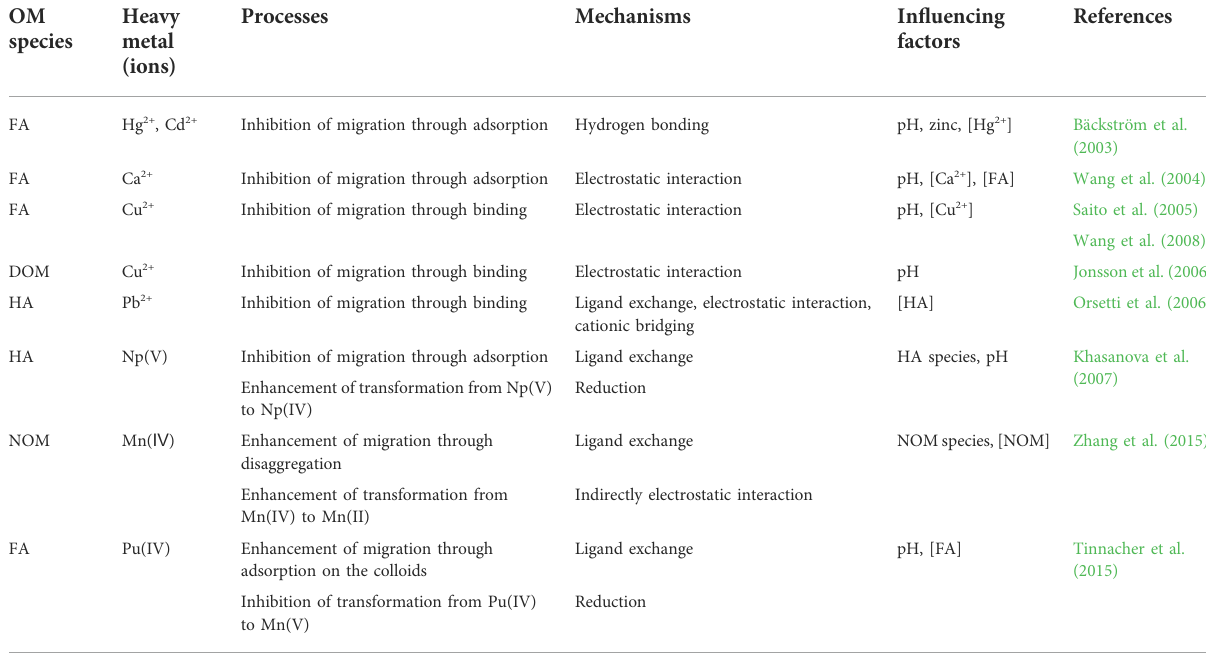
TABLE 2 Effect of goethite-OM complexes on migration and transformation of heavy metals. OM